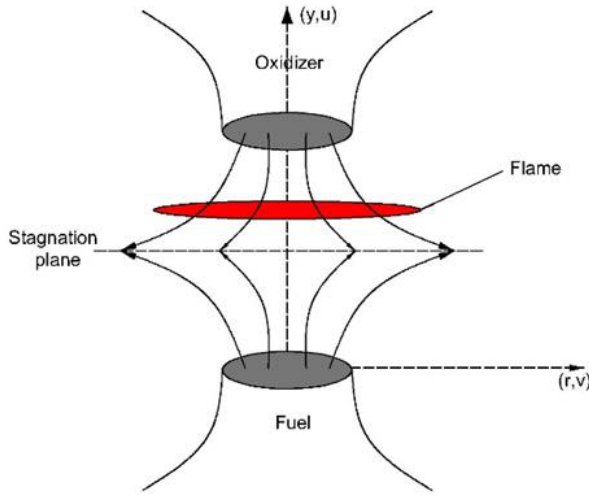
Figure 1. The configuration of the counterflow flame.